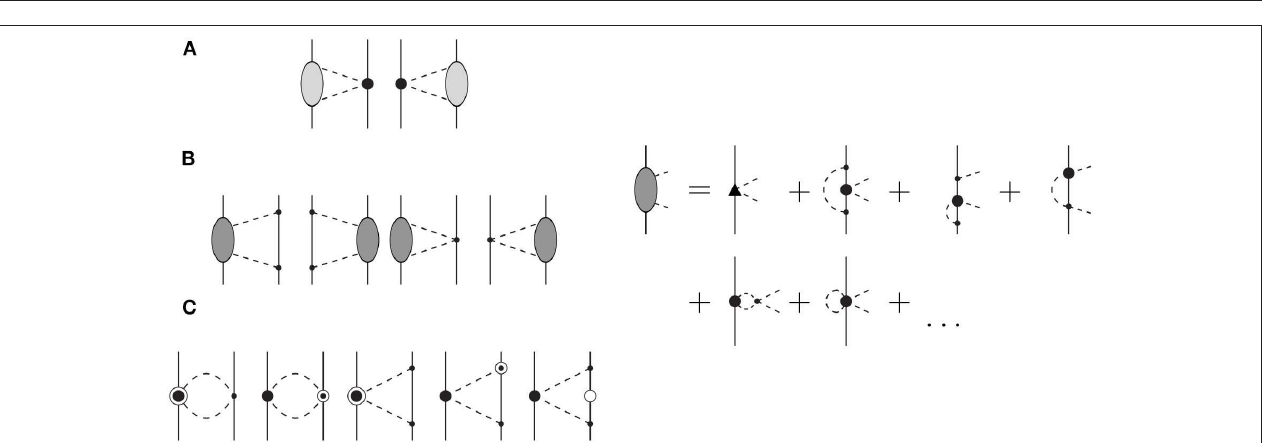
FIGURE 3 | N 3 LO 2 π -exchange contributions to the NN interaction. The same notation as in Figure 2 is use. Solid squares represent vertices with index 1 i Open circles and open circles with a dot inside are relativistic 1 / M N corrections to propagators and the vertex with one derivative, respectively. The leading one-loop π N amplitude is represented by a shaded oval. Adapted figure with permission from Entem et al. [ 46], copyright (2015) by the American Physical Society. (A) Football diagram, (B) two-loop diagrams, and (C) relativistic corrections to one loop diagrams.